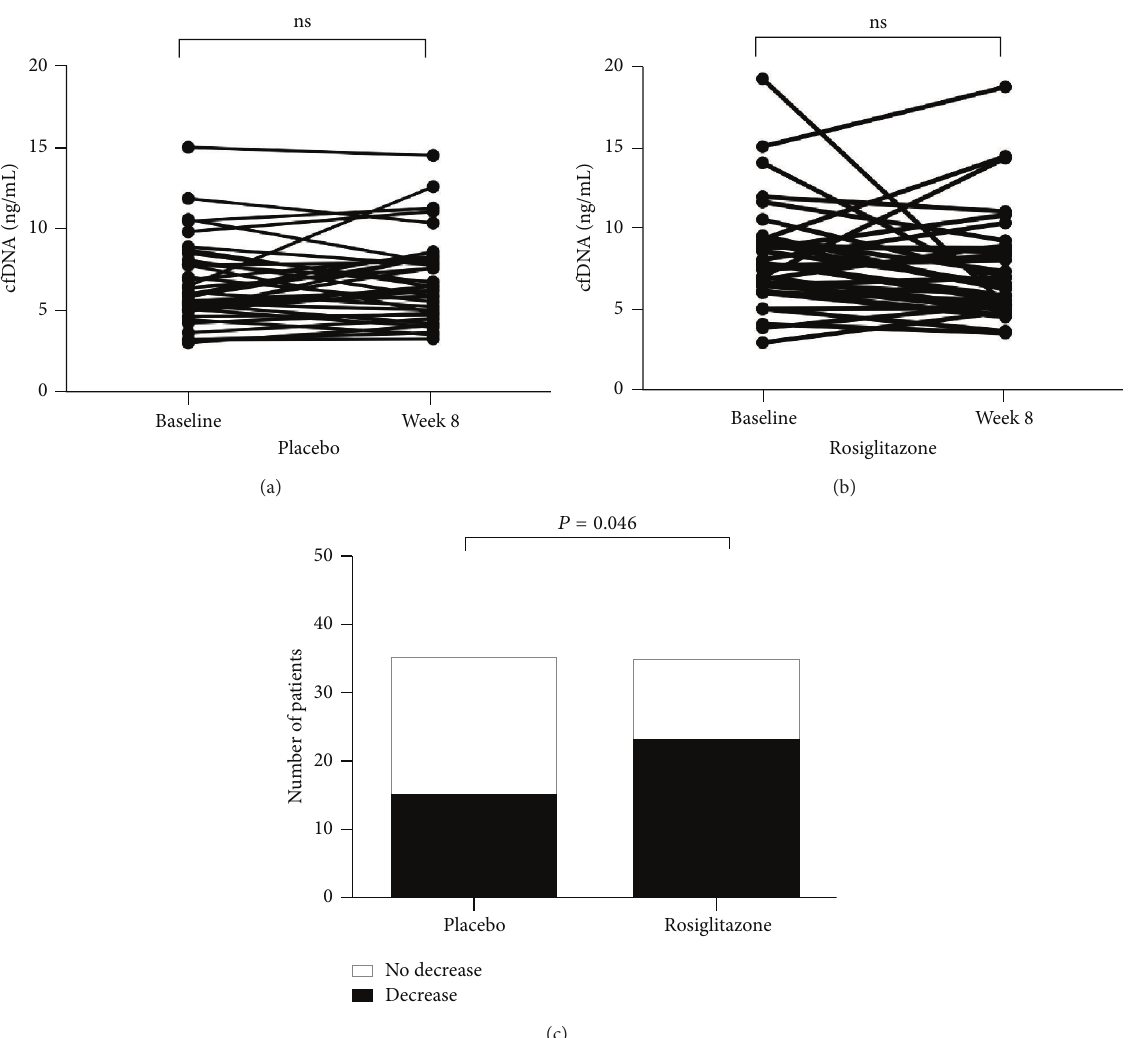
Figure 3: Changes in cfDNA levels. cfDNA levels were measured at baseline and following 8-week treatment with either placebo (a) or rosiglitazone (b). There were no differences between levels at baseline or follow-up in either group ( 𝑃 = 0.79 for placebo and 𝑃 = 0.11 for rosiglitazone). However, the proportion of patients who had a decrease in their cfDNA levels over the course of the trial was significantly higher in the rosiglitazone-treated group ( 𝑃 = 0.046 ), shown in (c) as the filled